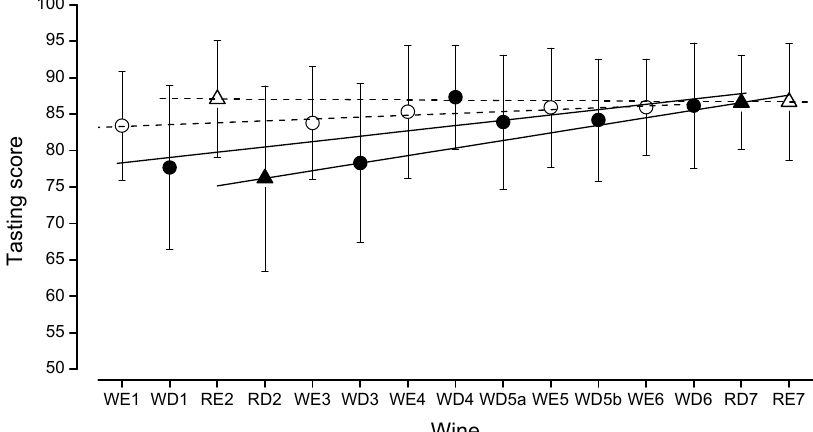
Figure 2. Evolution of tasting scores given by the 2012 panel to white and red wines (“easy” wines, open symbols; “difficult” wines, filled symbols; white wines, circles; red wines, triangles). Straight lines were obtained by linear regression of mean score values (“easy wines”, dashed lines; “difficult” wines, solid lines). Bars indicate standard deviations of the mean scores. Wine references are described in Table 4.